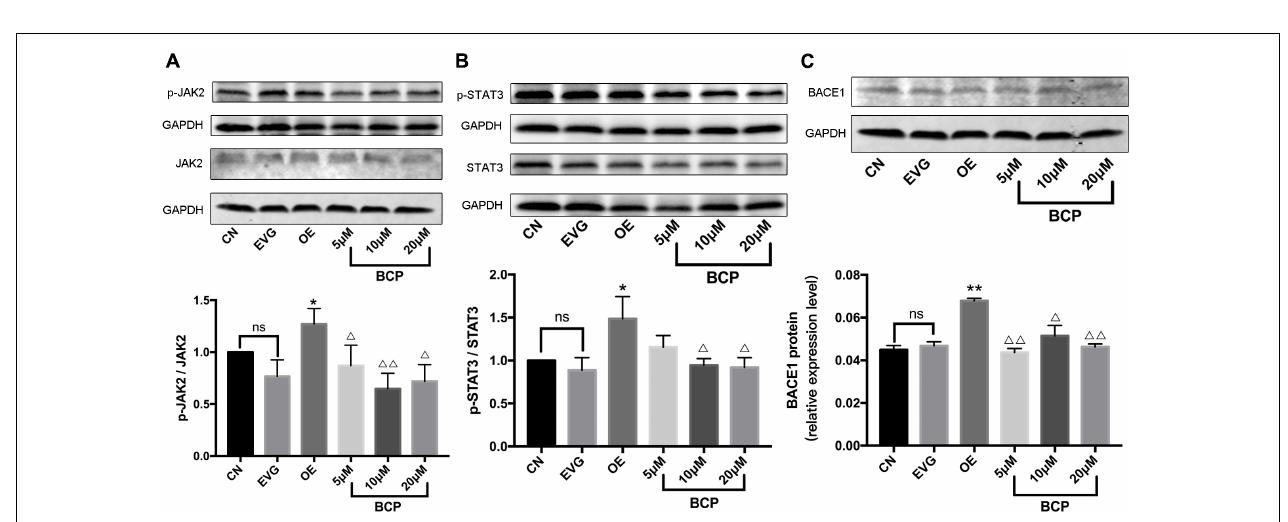
FIGURE 5 | Effect of β -caryophyllene on JAK2 and STAT3 phosphorylation and BACE1 protein expression in PC-12 cells. CN denotes the control group without special treatment; EVG denotes the empty vector group in which the PC-12 cells were transfected with plasmid vectors without gene fragments; OE denotes the group in which the PC-12 cells were transfected with a plasmid containing APP cDNA; and BCP denotes the group in which the effect of BCP on the 24-h viability of PC-12 cells transfected for 48 h was assessed. (A) Phosphorylation level of JAK2 protein. (B) Phosphorylation level of STAT3 protein. (C) Relative expression level of BACE1 protein. Compared with CN, ns p > 0.05. Compared with EVG, ∗ p < 0.05, ∗∗ p < 0.01. Compared with OE group, (cid:49) p < 0.05, (cid:49)(cid:49) p < 0.01. One-way ANOVA with Bonferroni’s post hoc